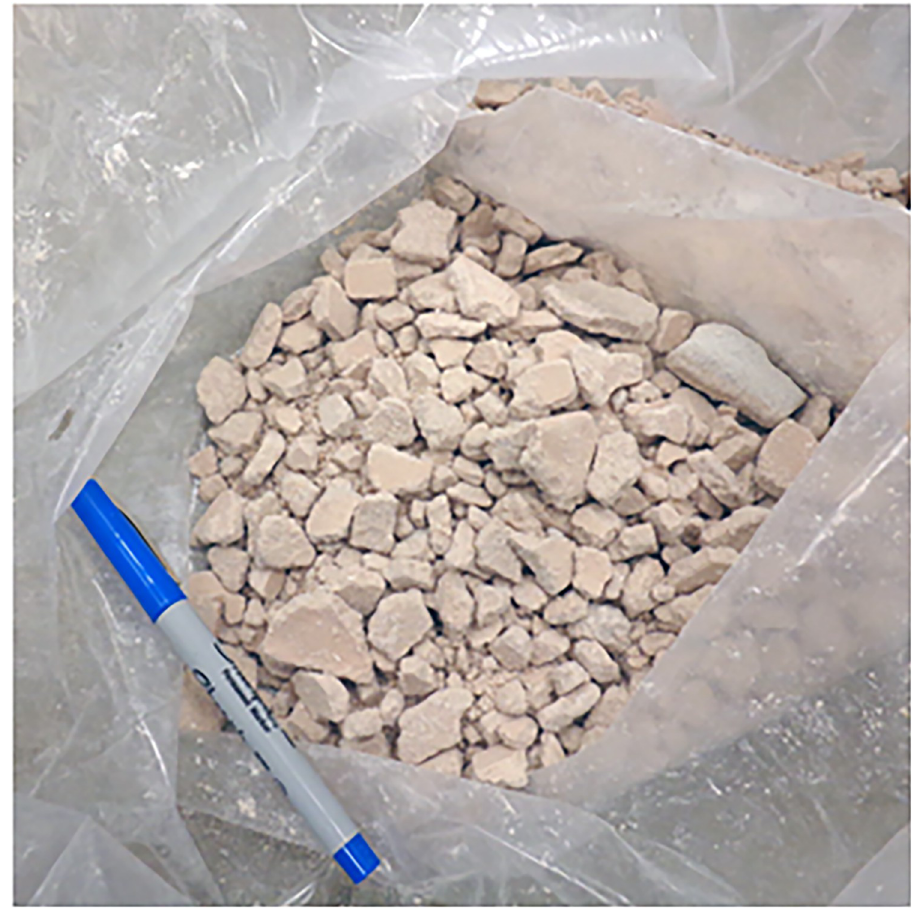
Fig 1. New process frozen Cohn fraction IV-4 stored in plastic bags at -80˚C. Gravel sized 1–3 cm pellets have a pink